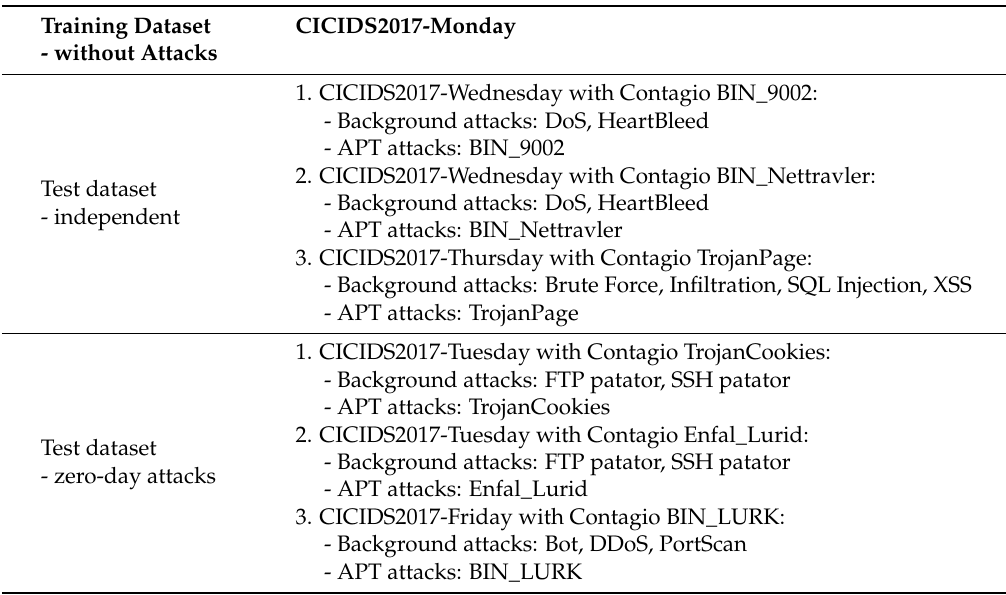
Table 2. Datasets and selected APT